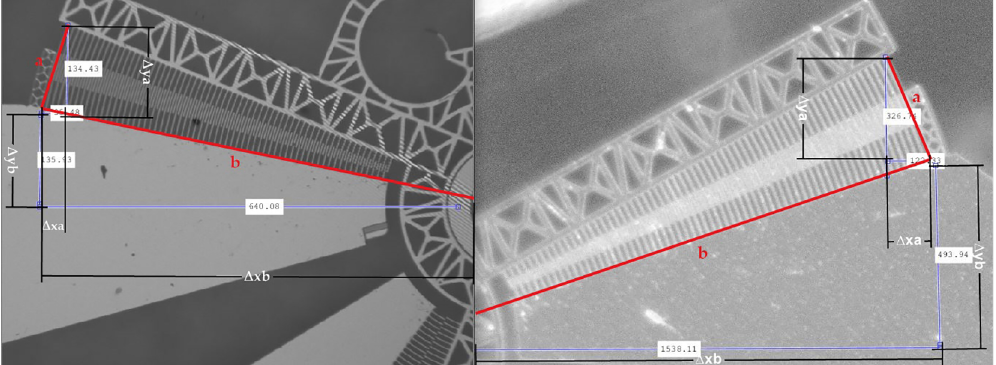
Figure 10. Angle measurement for the uncertainty evaluation related to the profilometer image, on the left and microscope image, on the right